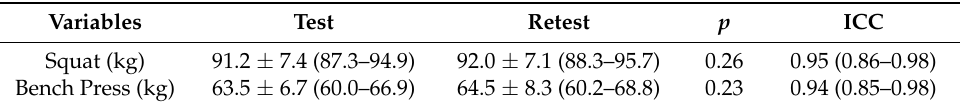
Table 1. 1 repetition maximum (RM) squat and bench press performance measured at familiarization